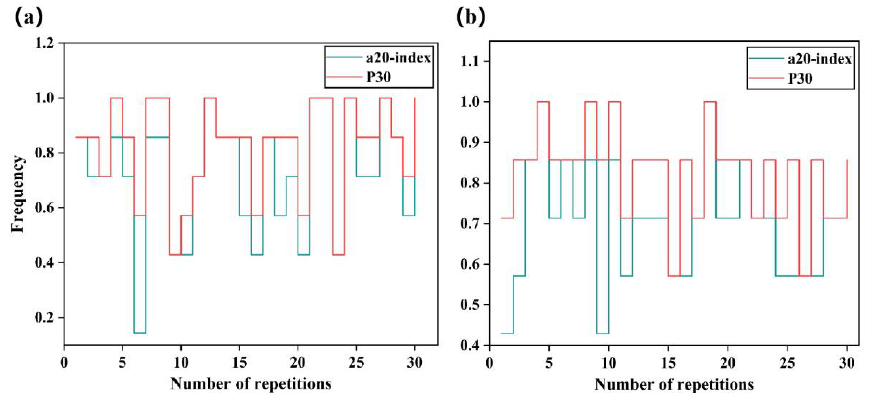
Figure 9. Repeated evaluation of model performance based on cumulative frequency of error: ( a ) for u p , ( b ) for Q u .